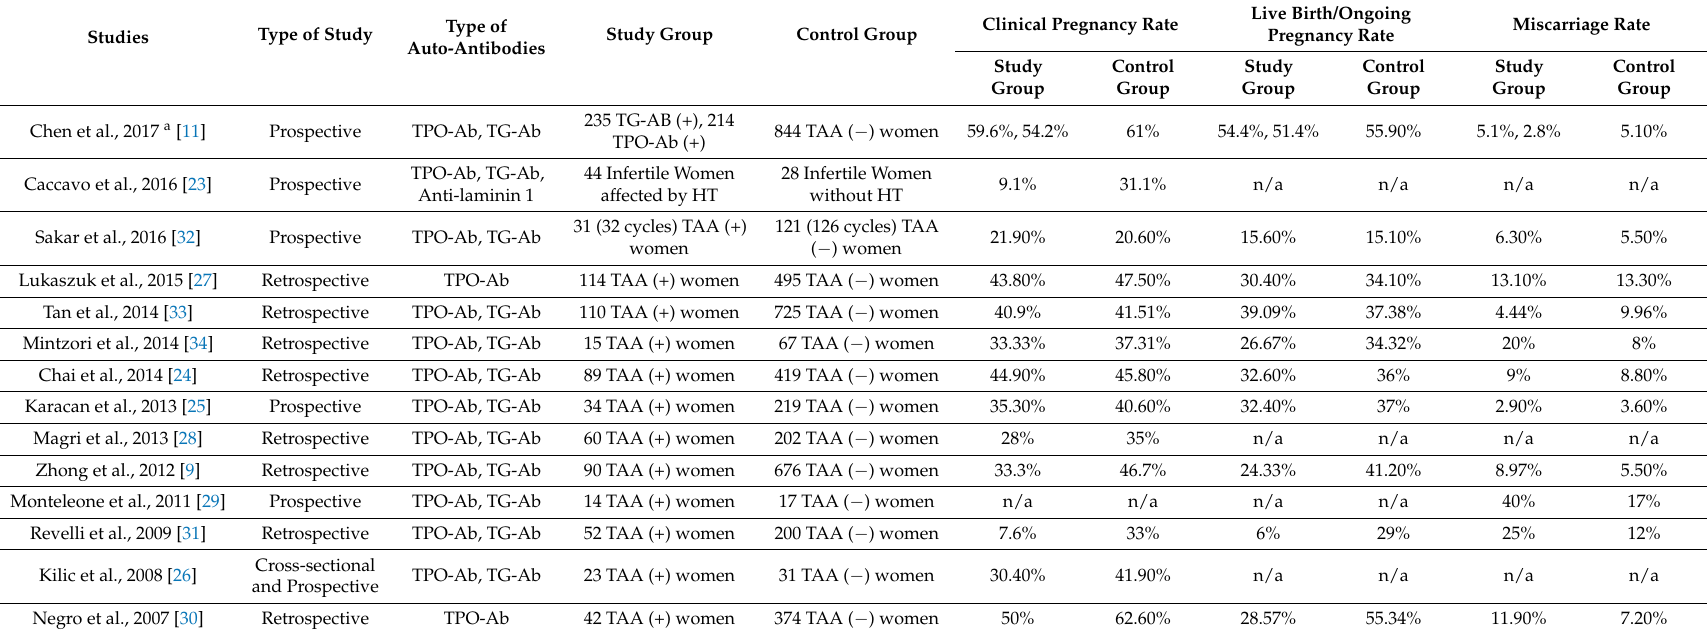
Table 1. Study characteristics regarding thyroid